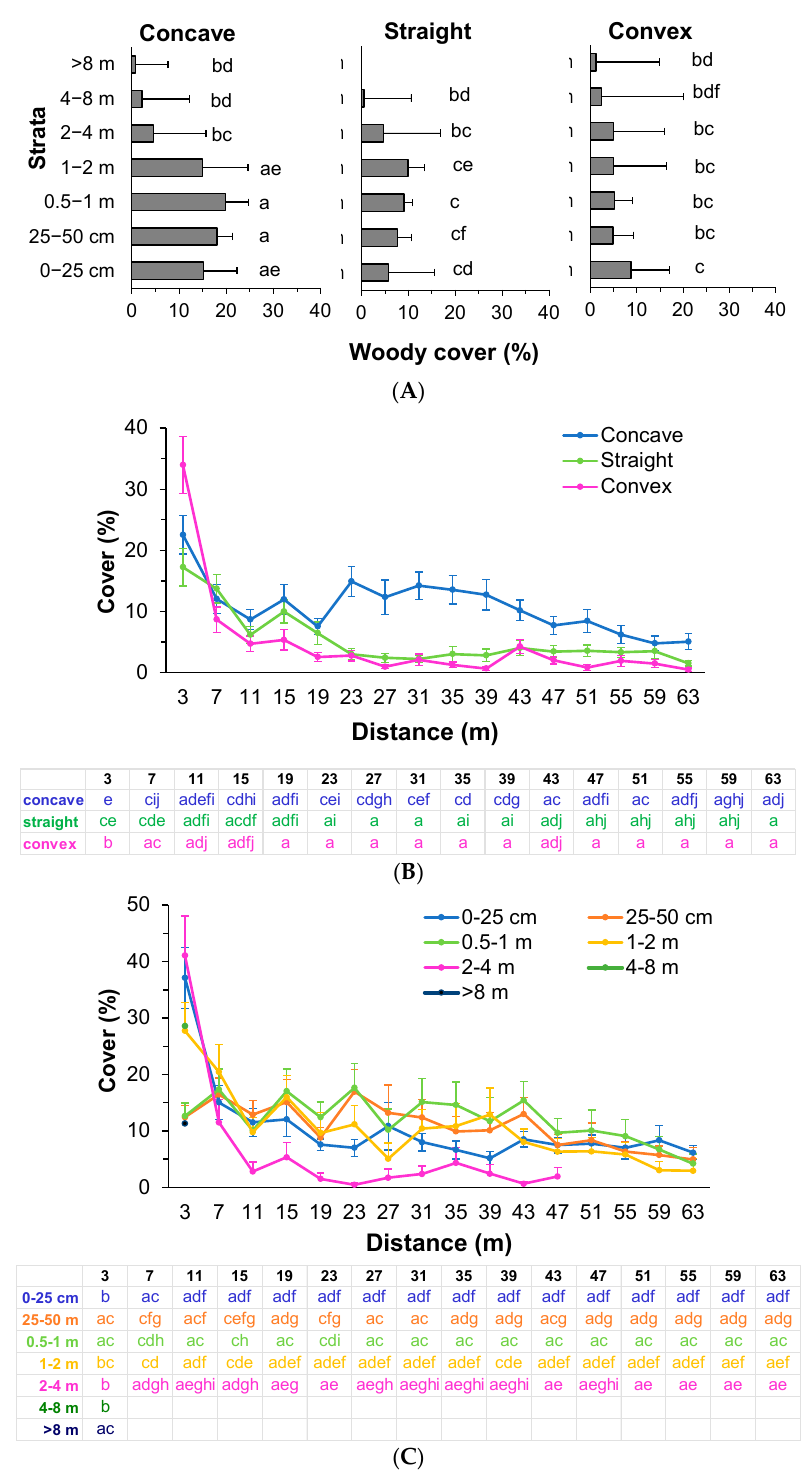
Figure 2. ( A ) Vertical structure of woody vegetation in the mines according to the boundary form. ( B ) Woody cover in the mines along with the distance from the forest-mine limit according to the boundary form. ( C ) Vertical structure of woody vegetation in the mines according to the distance from the forest edge. Mean cover and standard error are shown. Different letters indicate significant differences between all pairwise comparisons with Bonferroni’s test ( p < 0.05).